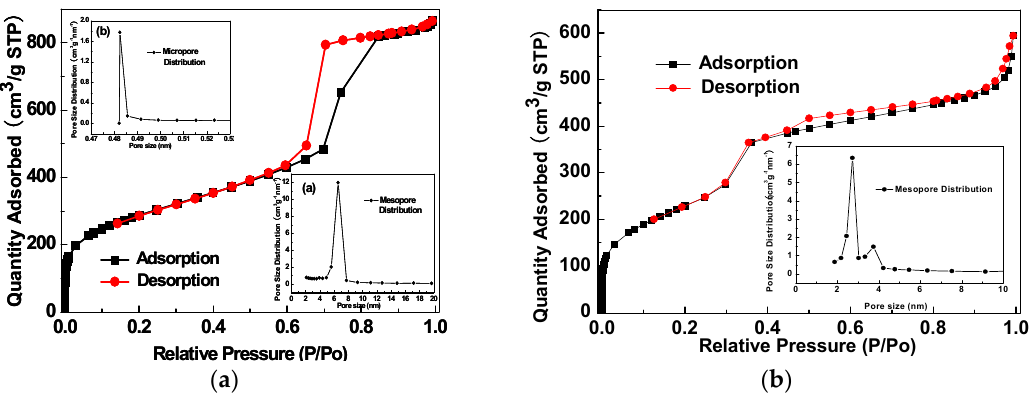
Figure 20. Nitrogen adsorption isotherms and pore size distributions of ( a ) SBA-15 and ( b ) MCM-48.